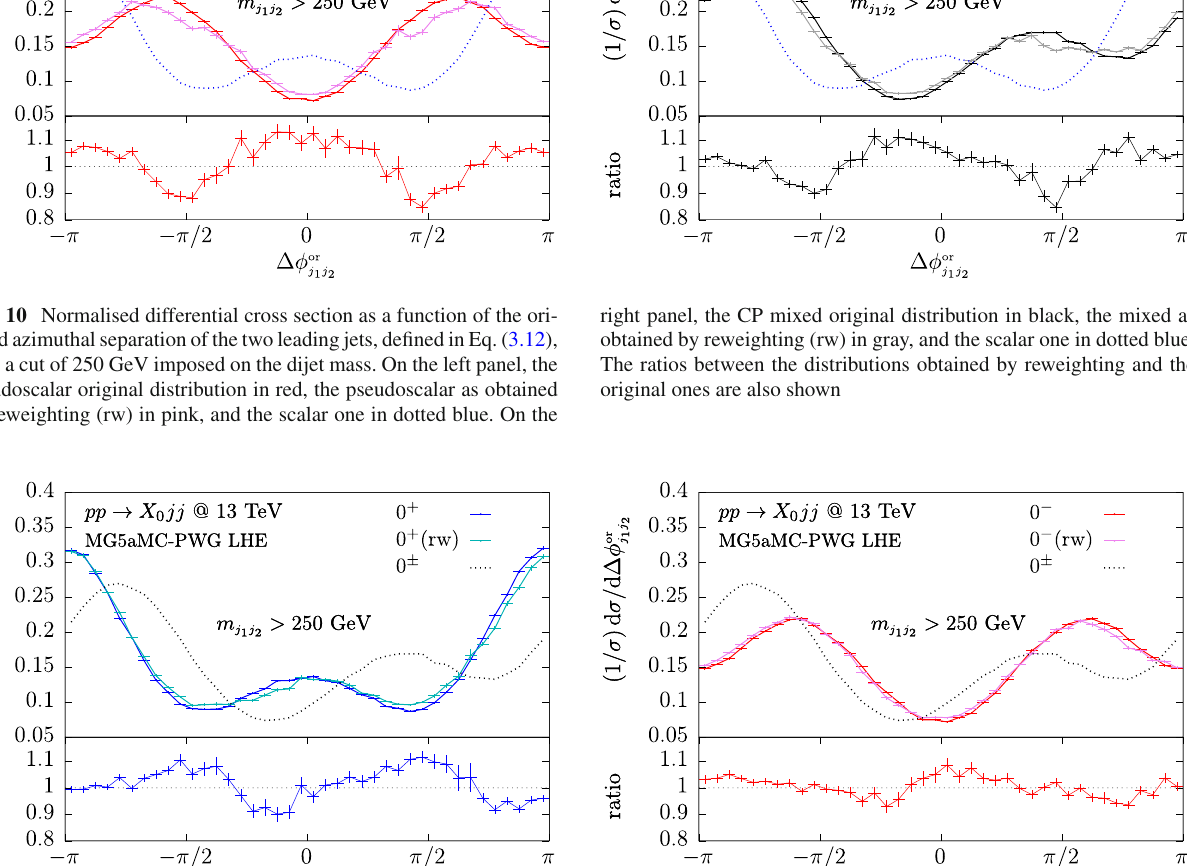
Fig. 11 Same as Fig. 10 but for the reweighting of the CP mixed sample to the scalar case (on the left) and to the pseudoscalar one (on the